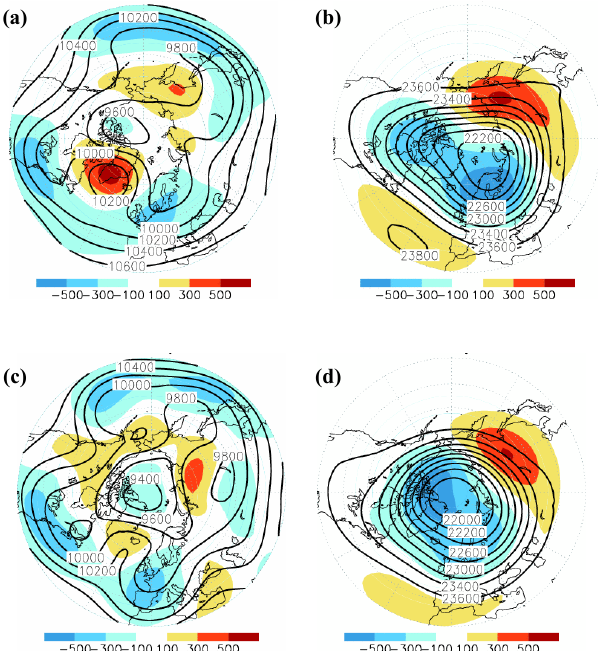
Fig. 10. Geopotential height (m; contour lines) and anomaly (m, Figure 10: Geopotential height (m; contour lines) and anomaly (m, colour shading) from its 6 colour shading) from its climatology (1980–2007) at 250hPa (a, c) climatology (1980-2007) at 250 hPa (a, c) and 30 hPa (b, d). (a, b) average for 1-5 January 7 and 30hPa (b, d) . (a, b) Average for 1–5 January 2010, (c, d) aver- 2010, (c, d) average for 6-10 January 2010. 8 age for 6–10 January